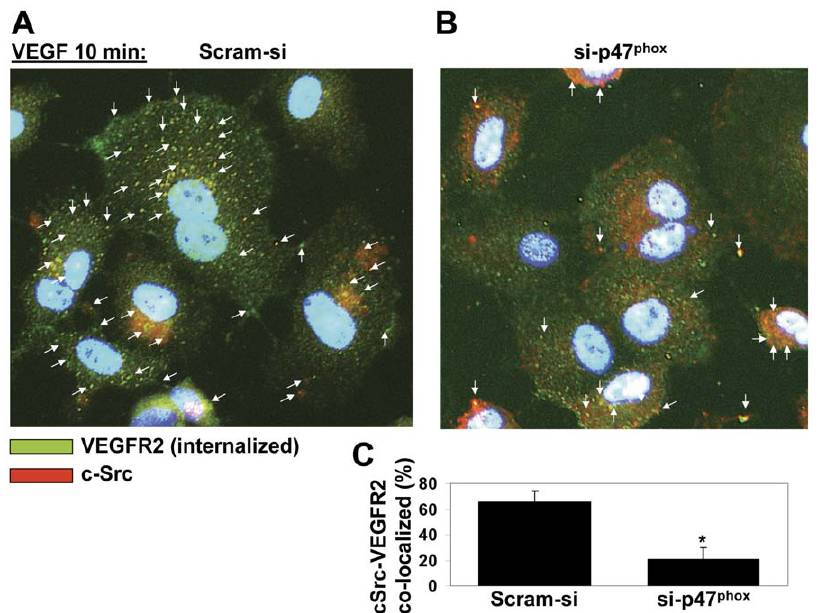
Figure 4. VEGF induces subcellular co-localization of c-Src and internalized VEGFR-2 in an ROS-dependent manner. HCAEC transfected with control (Scram-si) (A) or si-p47 phox (B) were immunofluorescently double labeled for internalized VEGFR-2 (green) and c-Src (red). VEGFR-2 on HCAEC was labeled with single chain E-tagged antibody (scFvA7, Fitzerald) as described in Materials and methods. After incubation with VEGF (50 ng/ml for 10 min), in order to remove the antibody from the cell surface, cells were placed on ice and acid washed. In permeabilized and fixed HCAEC, VEGFR-2 was detected with an AlexaFluor488-conjugated secondary antibody and is shown in green. c-Src was labeled with AlexaFluor647-conjugated secondary antibody (red) and nuclei with DAPI (blue). (B) Bar graphs show image analysis for colocalization events using the NIH Image J plugin (as described in Materials and methods). The graphs present the number of colocalization events normalized for the number of total VEGFR-2–positive immunofluorescence signals. Values are the mean of three experiments 6 S.E.M., each containing numbers obtained from five random fields. * p , 0.05 was considered statistically significant.